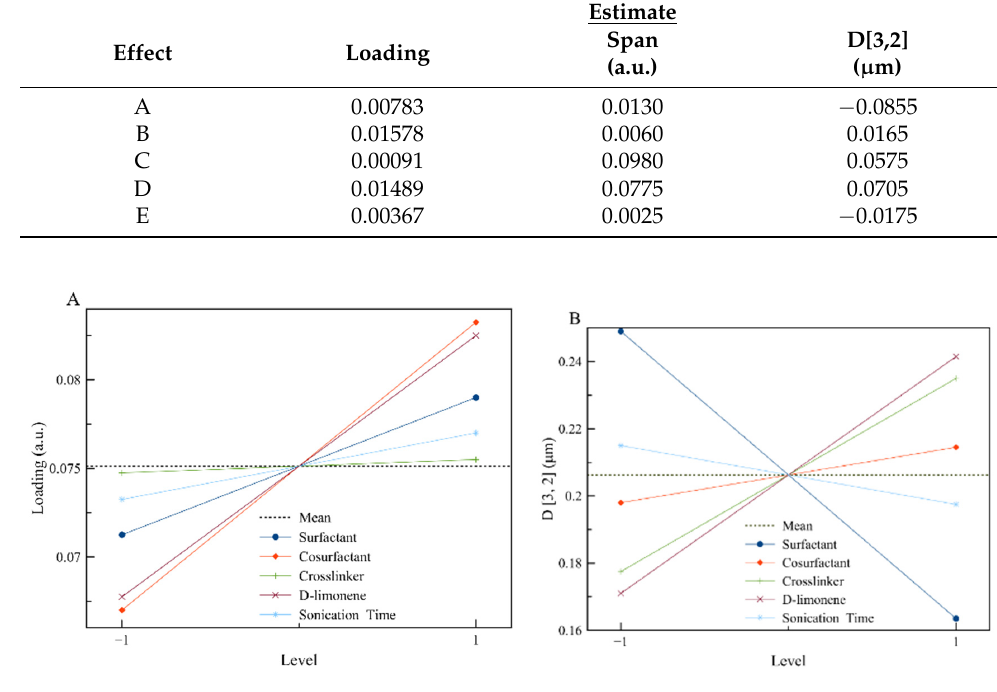
Figure 2. The main effect plots for the responses of interest: ( A ) Loading and ( B ) D[3,2], respectively.